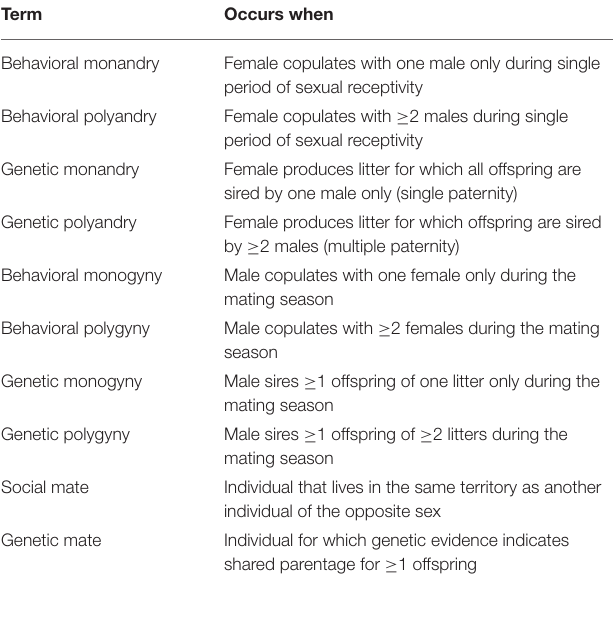
TABLE 1 | Behavioral and genetic definitions for monandry, polyandry, monogyny, polygyny, social mate, and genetic mate for white-tailed prairie dogs.